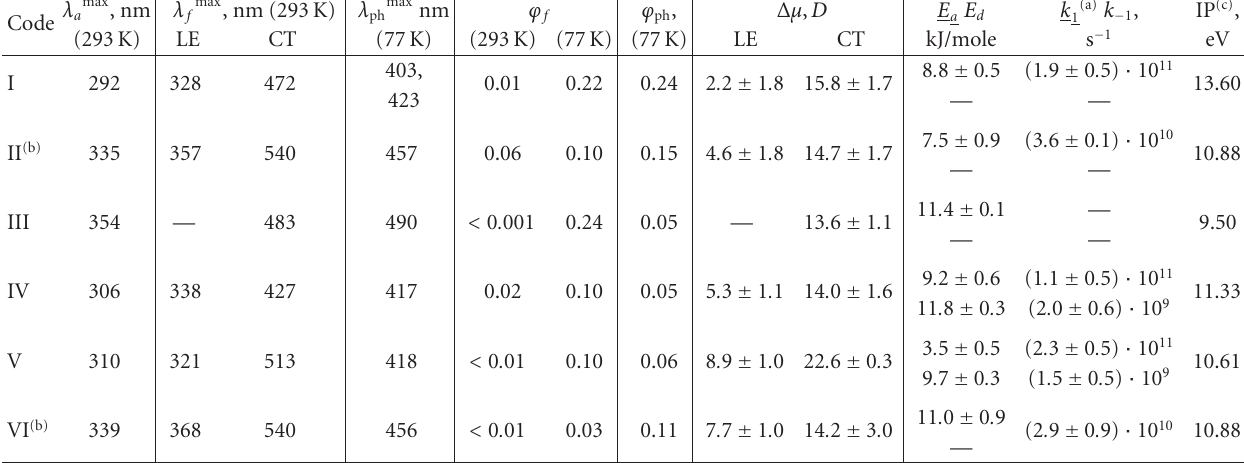
Table 1: Absorption, fluorescence, and phosphorescence band maxima ( λ a max , λ f max , λ phmax ), fluorescence and phosphorescence quantum yields ( ϕ f , ϕ ph ), dipole moment changes ( Δ μ = μ e − μ g ), activation energies ( E a , E d ), rate constants of forward and backward reactions ( k 1 , k − 1 ) of compounds I–VI in ethanol and ionization potentials (IPs) [8].